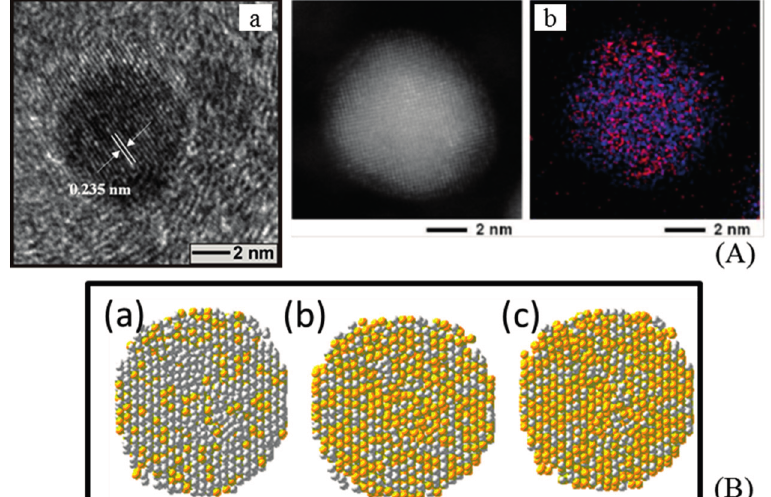
Figure 2. ( A ) HRTEM (a) and EDS (b) composition mapping for Au 22 Pt 78 /C (red: Pt,